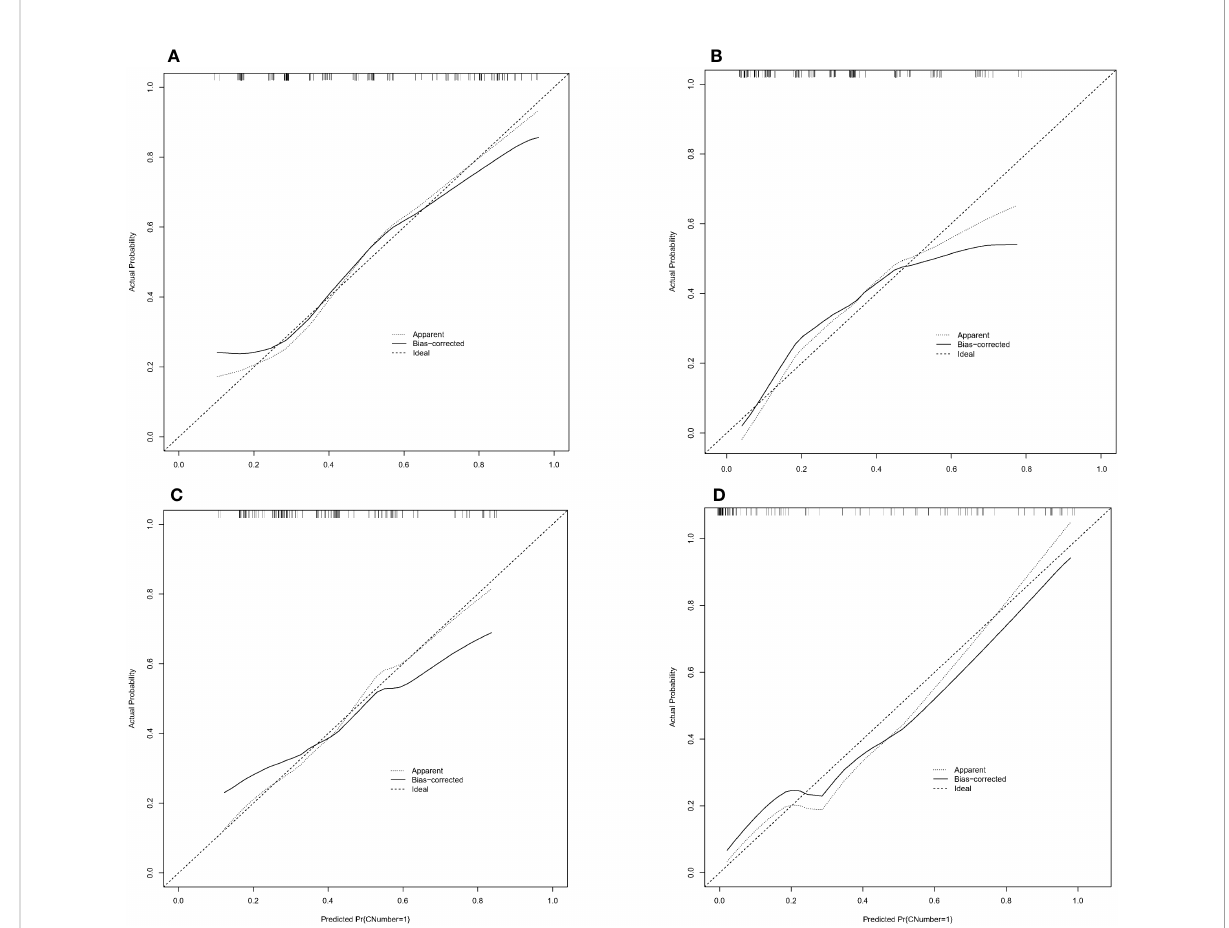
FIGURE 7 The calibration curve for (A) ipsilateral central lymph node metastasis (CLNM), (B) contralateral central lymph node metastasis (CLNM), (C) 1-4 central lymph node metastasis (CLNM), (D) >5 central lymph node metastasis